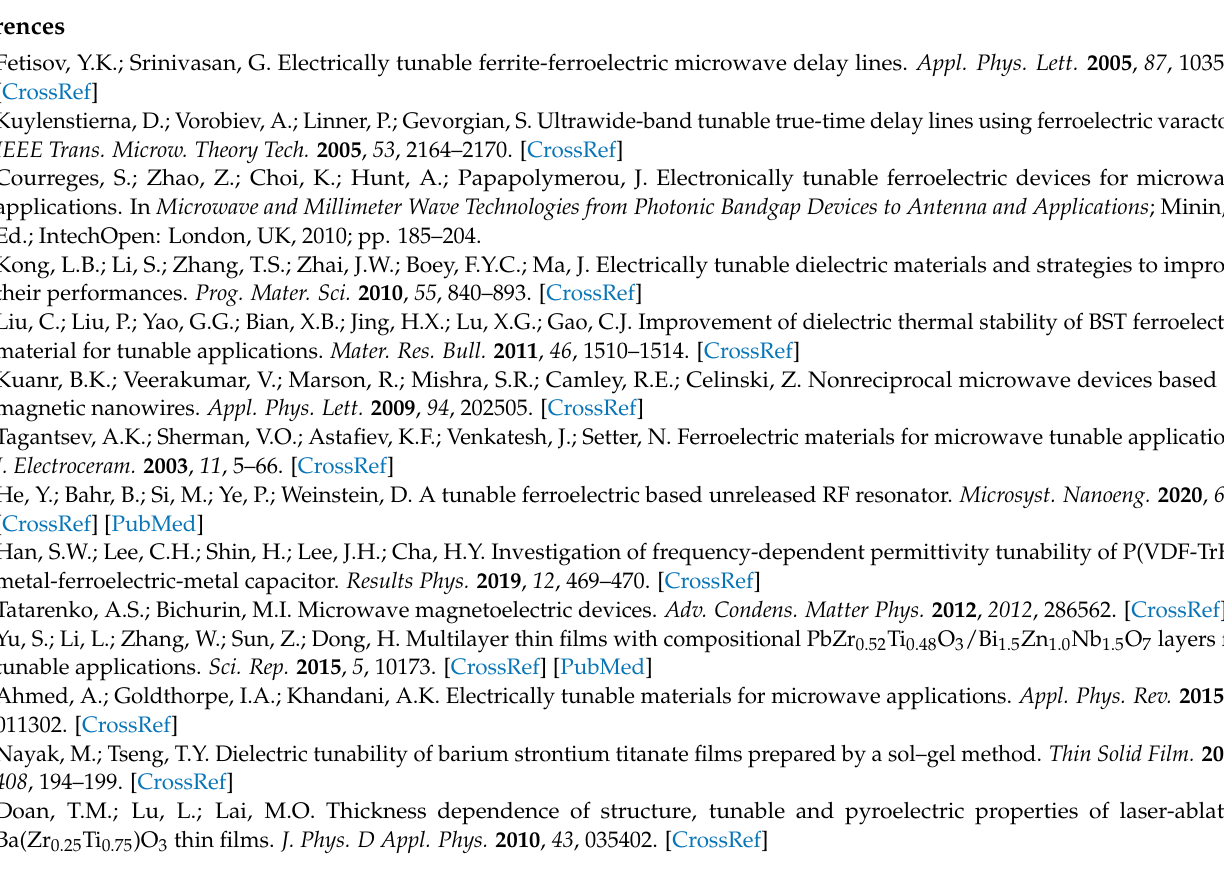
Figure S2: (a) Polarization hysteresis ( P - E ) loops and (b) corresponding switching current ( I SW -E ) curves of PLZT films with various film thicknesses, measured at 800 kV/cm and 1 kHz. (c) P-E loops and (d) corresponding I SW -E curves of 1000-nm PLZT film, measured at 1 kHz and under different applied electric fields (400, 800 and 1800 kV/cm); Figure S3: (a) Dielectric constant versus temperature depen- dence at various frequencies. Zoom in (b) low-field region of Figure 2c, (c) high-field region of Figure 2c and (d) high-field region of Figure 2d; Figure S4: (a) Dependence of dielectric constant at zero-bias field ( ε r ,0 V ) of 1000-nm film at E ap,max of 800 kV/cm on frequency. (b) Inverse capacitance density ( A / C eff ) and ε r ,0 V value as a function of PLZT film thickness; Figure S5: (a) Normalized dielectric constant at zero field ( ε r ,0 V ) and the difference between ε r ,0 V and ε E , (dielectric at certain bias field) ap,max as a function of frequency. (b) Normalized tunability ( T ) and figure-of-merit ( FOM ) as a function of frequency. The measurements were done at 800 kV/cm for 1000-nm PLZT films; Figure S6: (a) Polarization hysteresis ( P-E ) loop and switching current curve, measured at 200 kV/cm and 1 kHz; (b) Dielectric constant curves measured at 1 kHz and various maximum applied electric fields ( E ap,max of 250 and 500 kV/cm), of normal-ferroelectric Pb(Zr 0.52 Ti 0.48 )O 3